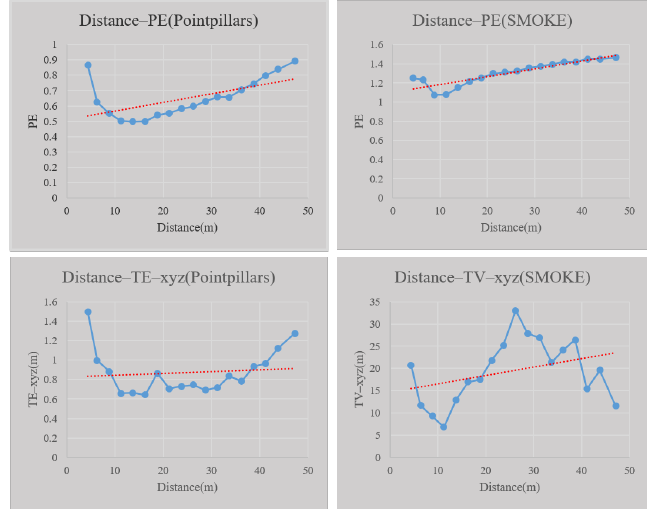
Figure 15. The relationship between object distance and perception uncertainty. The red line in Figure 16 shows the trend between the occlusion factor and the pre- diction entropy, TV, and TE of location. The blue line is the scatter plot line between these factors. The Pearson coefficients between prediction entropy, TV, and TE of Pointpillars are 0.665, 0.505, and 0.987, respectively. In general, the higher the degree of occlusion, the higher the uncertainty of objects detected. However, the prediction entropy and TV in this study show a downward trend when the occlusion degree is 3. This is related to the data distribution of the KITTI dataset. There are very few sample data with an occlusion degree of 3, resulting in statistical result errors. However, there is a positive correlation between the perception uncertainty and the degree of occlusion in the sample.